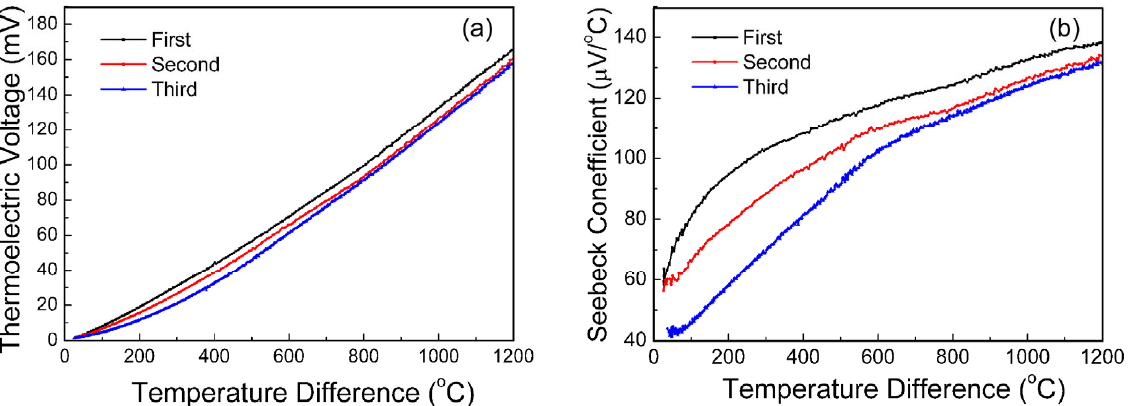
Figure 8. Output calibration and Seebeck coefficient change of In 2 O 3 /ITO thermocouple. ( a ) Thermal voltage output; ( b ) Seebeck coefficient.